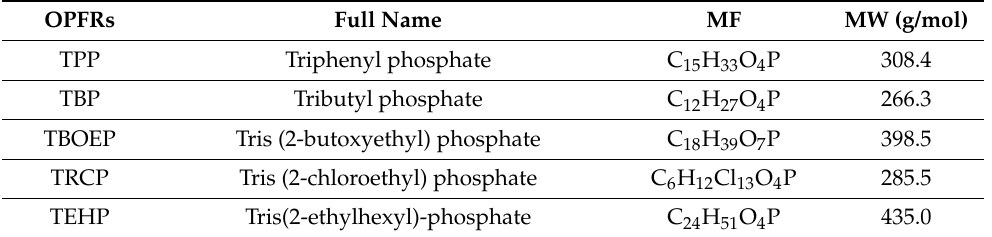
Table 1. A compilation of some major OPFRs with MF, MW (g/mol) [5,7,11].